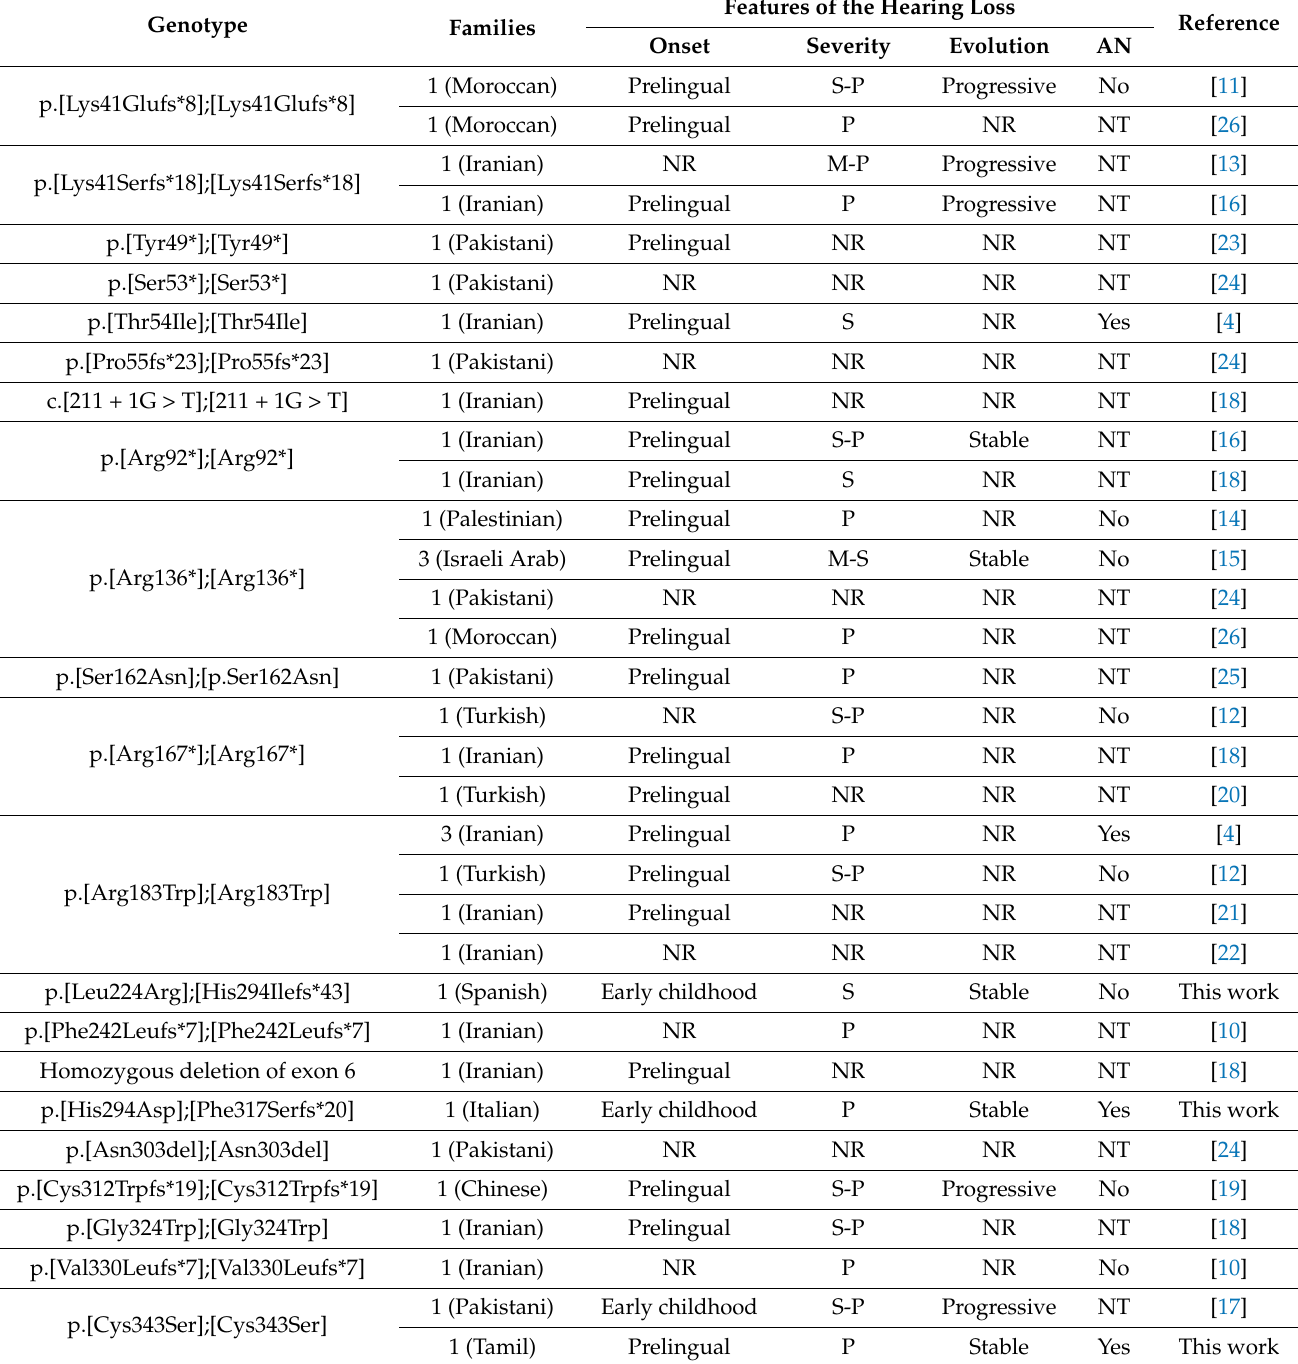
Table 4. Genotypes and phenotypes observed in subjects with the DFNB59 type of autosomal recessive hearing